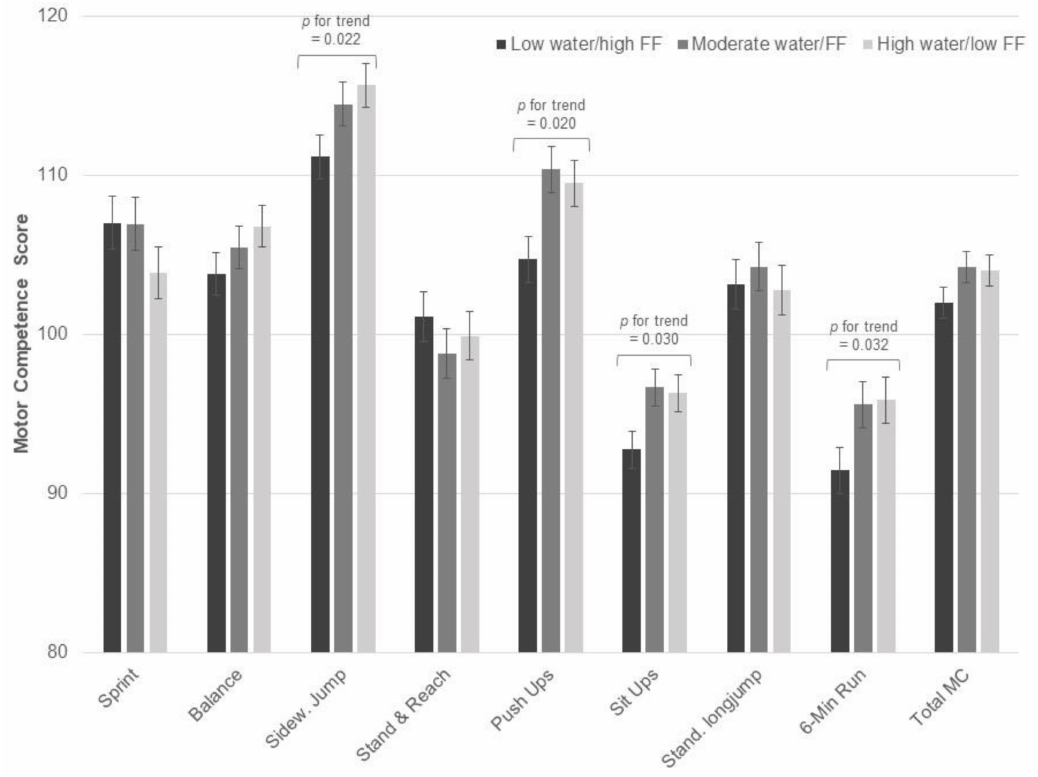
Figure 2. Main effects of club sports participation on motor competence based on 2 × 3 MANOVA (club sports by Water/low FF). Values are sex-and age-normalized means with